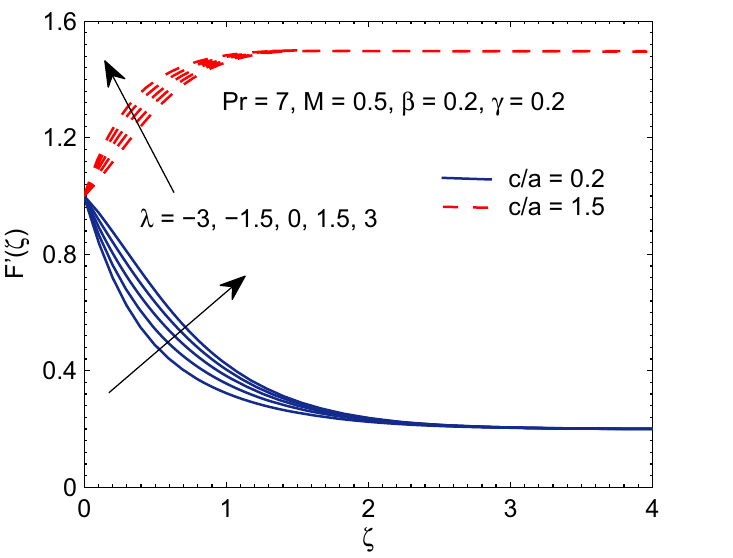
Fig 5. Profiles of F 0 for different values of mixed convection parameter γ